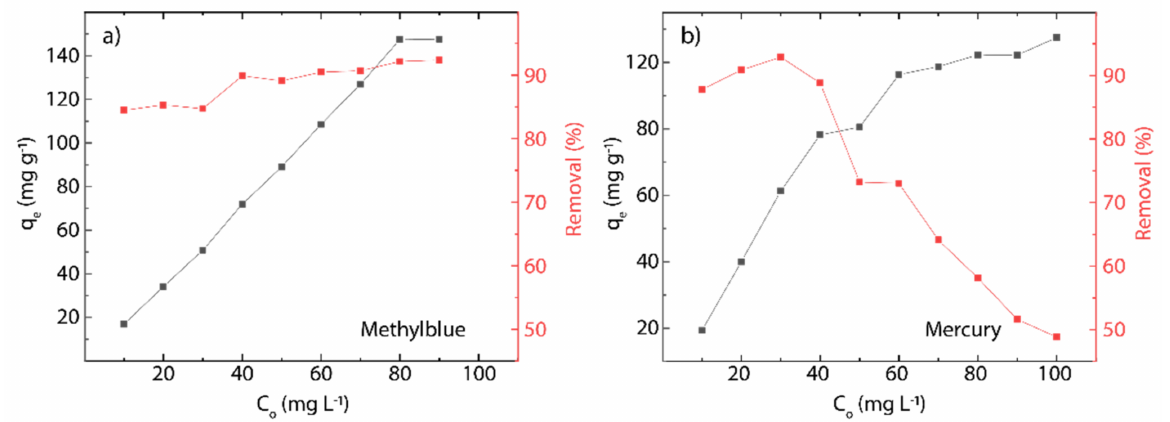
Figure 10. Effect of the initial concentration on the adsorption process at 298 K of ( a ) MB or rGO and ( b ) Hg(II) on rGO. Adsorption capacity (black markers) and removal percentage (red